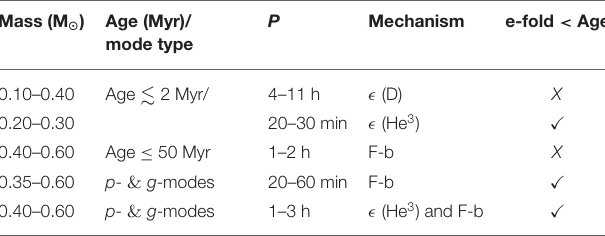
TABLE 1 | Summary of pulsation analysis by RL14 sorted by excitation